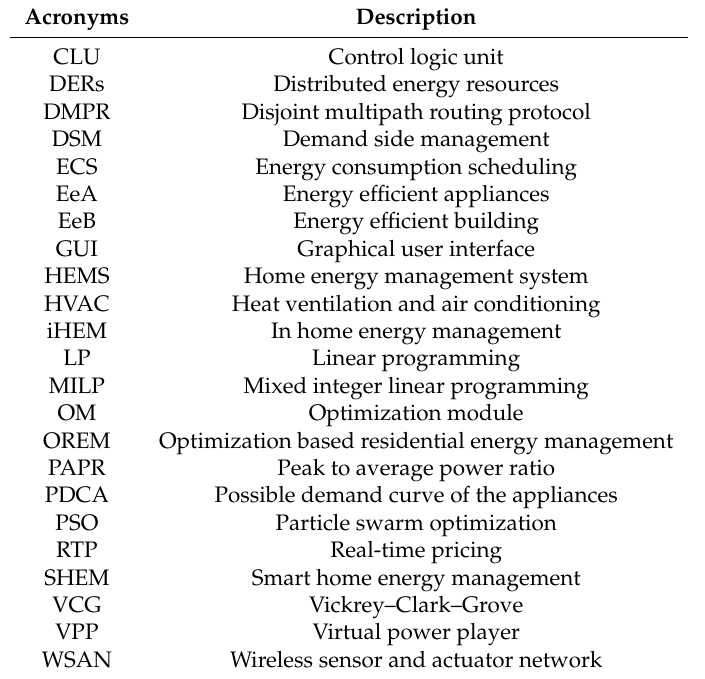
Table 1. List of acronyms and their descriptions.